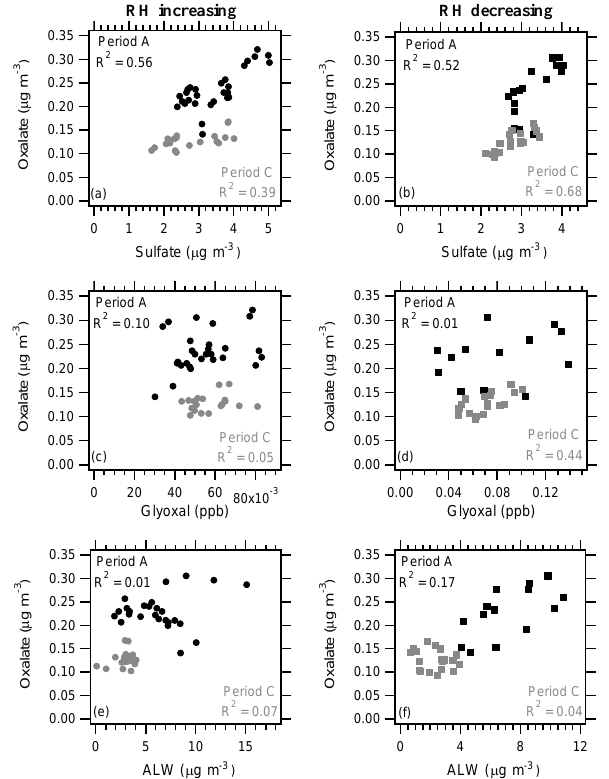
Figure 8. Correlation of hourly averaged oxalate vs. sulfate for Pe- riods A and C during the times of RH (a) increasing and (b) de- creasing, gas-phase glyoxal for Periods A and C during the times of RH (c) increasing and (d) decreasing, and ALW for Periods A and C during the times of RH (e) increasing and (f) decreasing at SPC.